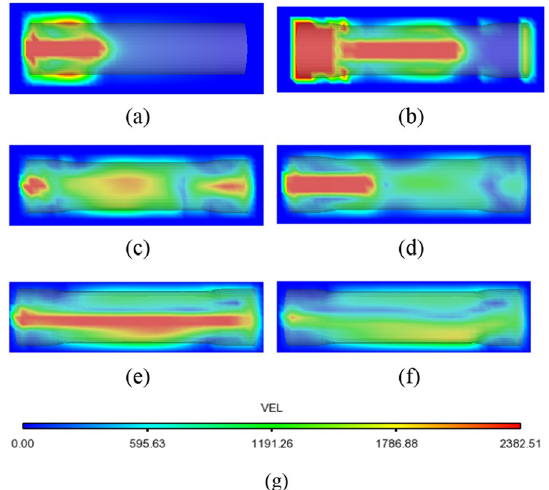
Figure 19 Cloud maps of fluid velocity in the axial section: ( a ) Cloud map of fluid velocity at 0.01 s, ( b ) Cloud map of fluid velocity at 0.02 s, ( c ) Cloud map of fluid velocity at 0.06 s, ( d ) Cloud map of fluid velocity at 0.12 s, ( e ) Cloud map of fluid velocity at 0.17 s, ( f ) 0.2 s fluid velocity cloud map, ( g ) Contour fluid velocity cloud map